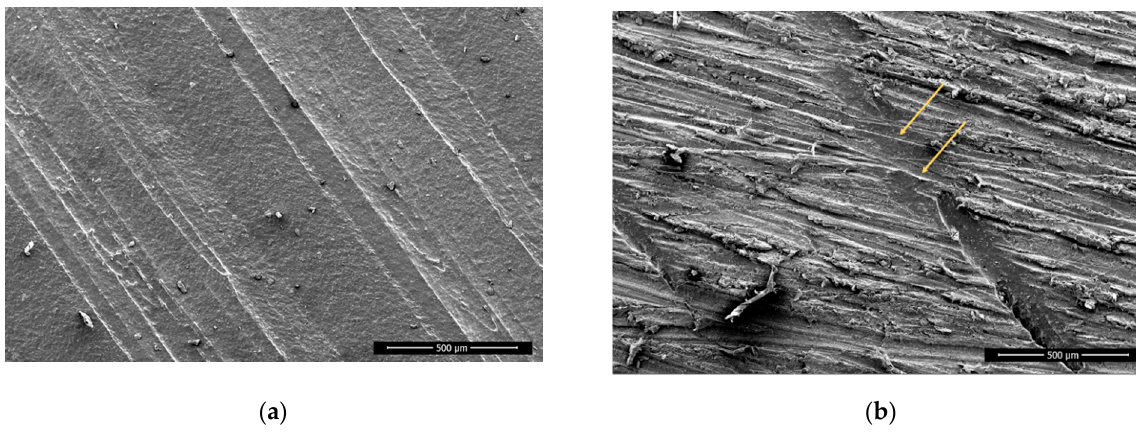
Figure 2. ABS, non-sanded, non-treated ( a ) and sanded ( b ), 100× magnification; arrows pointing to the sanding traces.